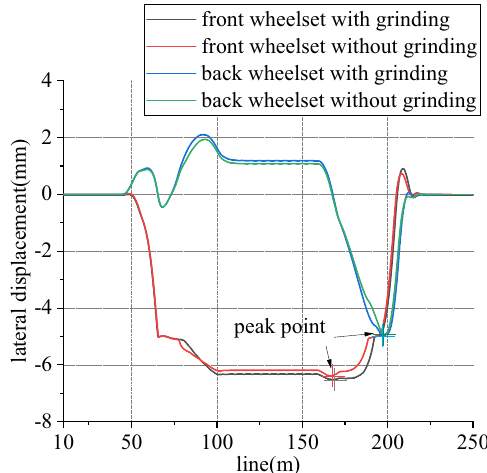
Figure 12. Lateral displacement of wheelsets (typical case).